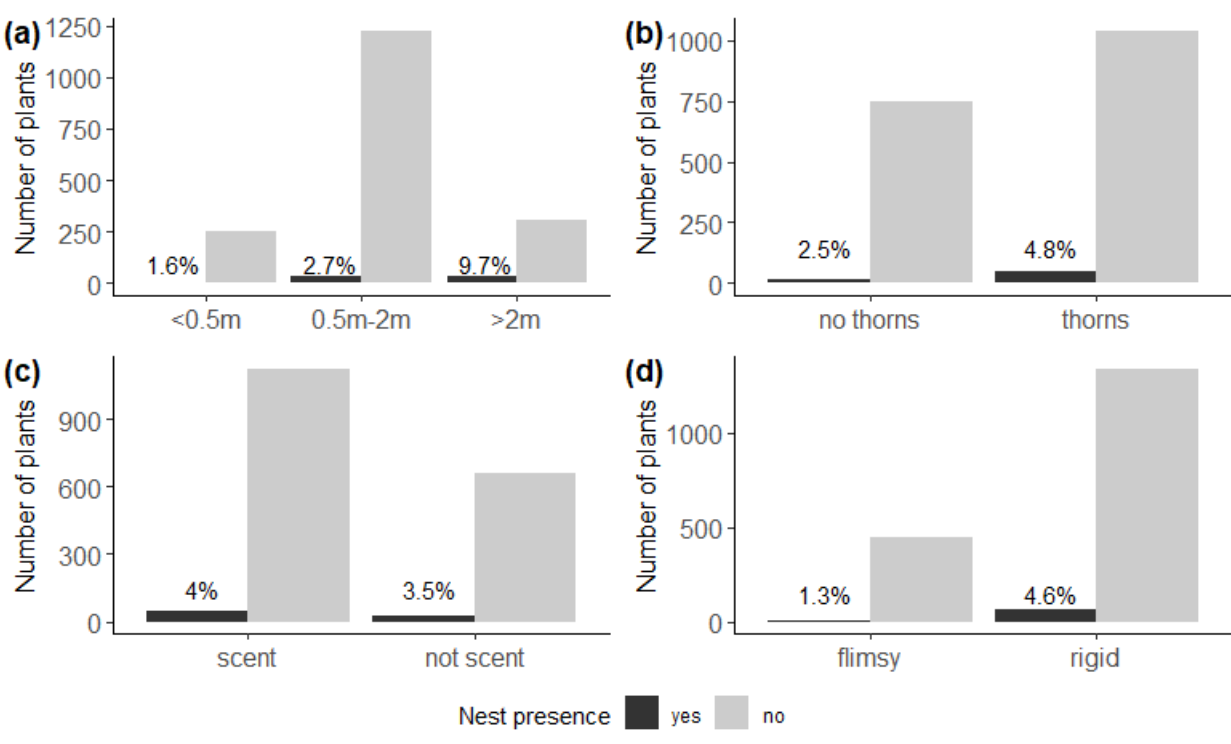
Figure 3. Number of potential host plants with (black) and without (grey) nests of Stegodyphus dumicola Pocock, 1898, according to ( a ) plant height, indicating more nests on plants higher than 2 m ( χ 2 = 39.6, df = 2, p < 0.001); ( b ) spinosity, indicating more nests on host plants with thorns ( χ 2 = 5.72, df = 1, p = 0.02); ( c ) scent, indicating no effect of odour or scent on nest presence ( χ 2 = 0.18, df = 1, p = 0.67); and ( d ) structure, indicating more nests on plants with a woody rather than flimsy structure ( χ 2 = 9.23, df = 1, p < 0.01). Percentages indicate the proportion of host plants with a nest.